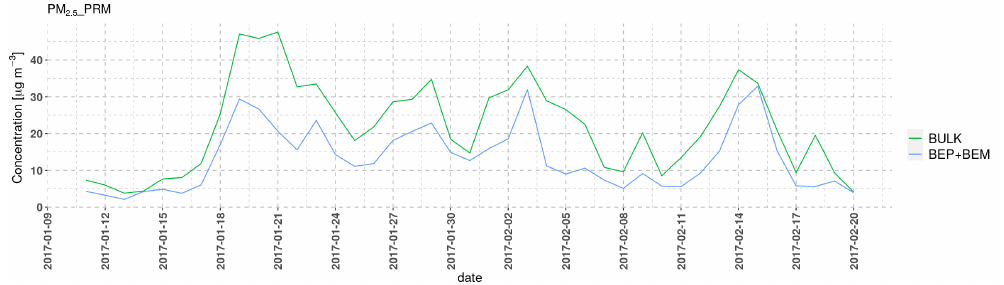
Figure 10. Average daily concentrations of PM primary aerosol for BULK simulations (green) and BEP+BEM simulations